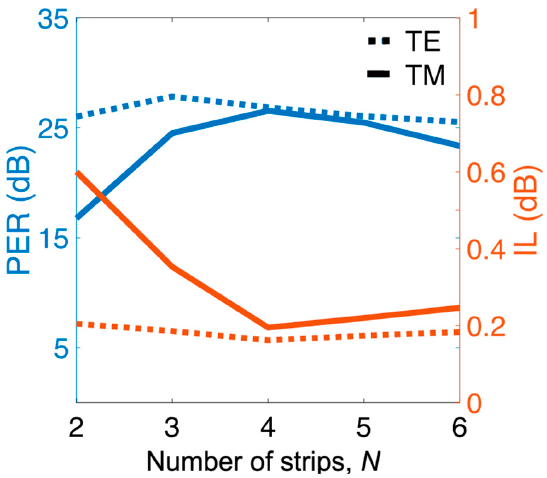
Figure 7. (left axis) PER and (right axis) IL of both modes as a function of the number of Si strips, N between slot waveguides at the same parameters as those in Figure 5.